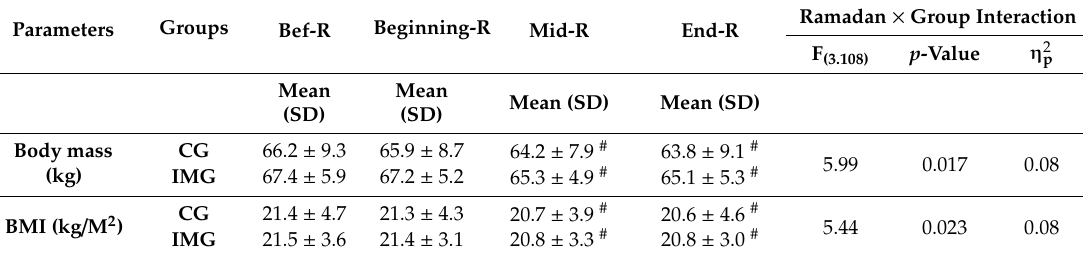
Table 3. Averages ( ± SD) of body mass and BMI recorded before and during Ramadan.